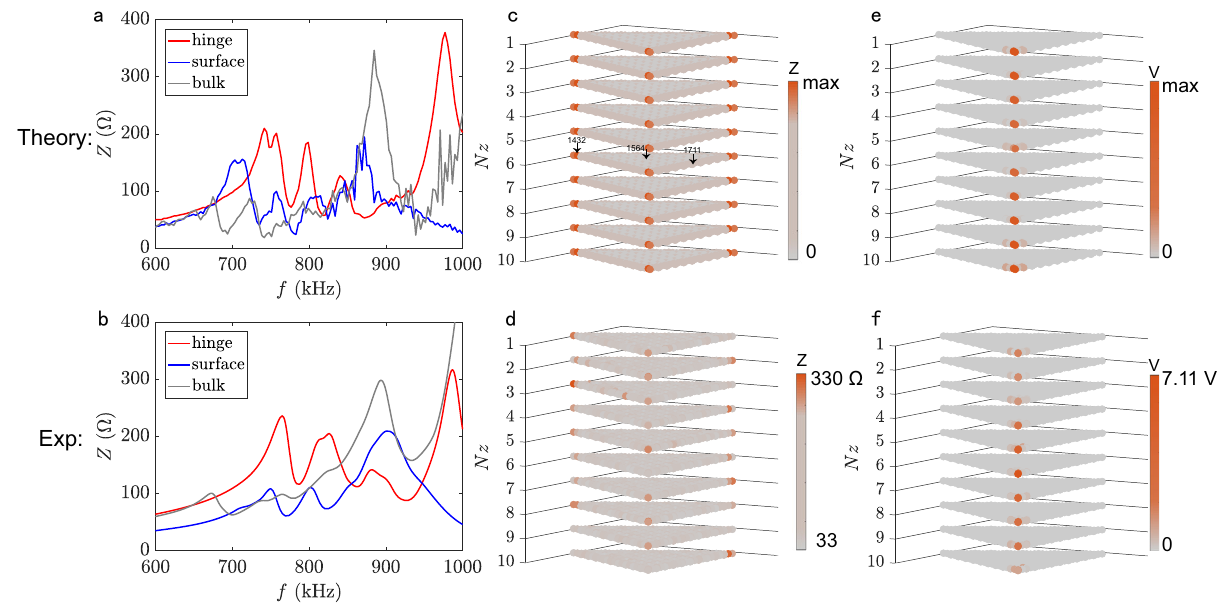
Fig. 3 | Impedances spectra, impedances and voltage distributions. a Theoretical impedance versus the driving frequency in a disordered circuit. b Measuredimpedanceasafunctionofthefrequency.Calculated( c )andmeasured